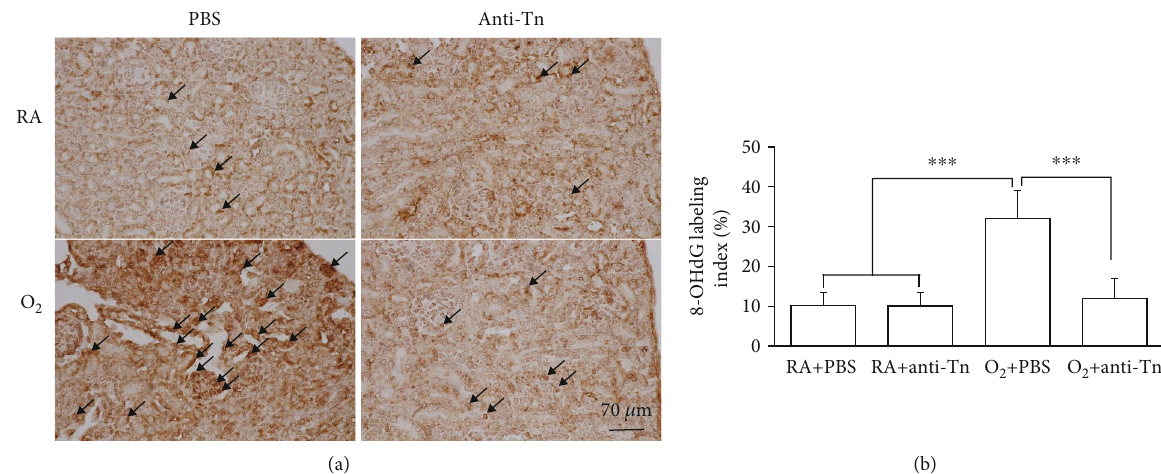
Figure 2: (a) Representative immunohistochemistry of 8-OHdG and (b) semiquantitative analysis of 8-OHdG-positive cells on postnatal day 7. The mice reared in hyperoxia and treated with PBS exhibited signi fi cantly more 8-OHdG-positive cells (black arrow) than did the RA-reared mice treated with PBS or anti-Tn monoclonal antibodies, and anti-Tn monoclonal antibody treatment reduced the hyperoxia- induced increase in 8-OHdG-positive cells. ∗∗∗ P < 0 : 001 .